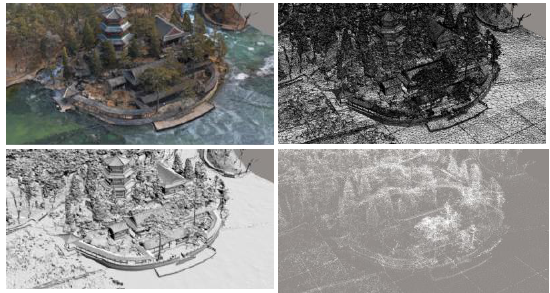
Figure. 8 3D model generation by photogrammetry of Jinshan UAV(From Xie Lindong)